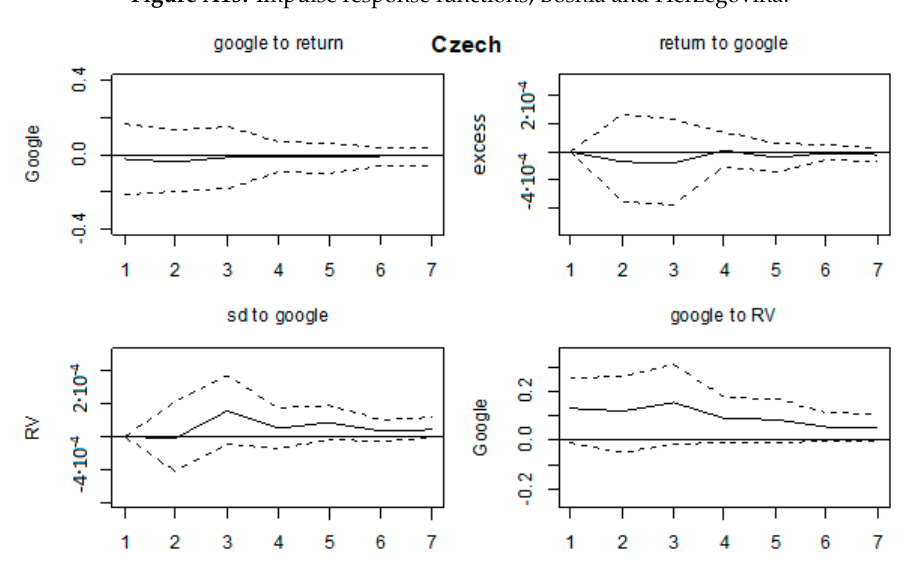
Figure A16. Impulse response functions, Czech Republic.